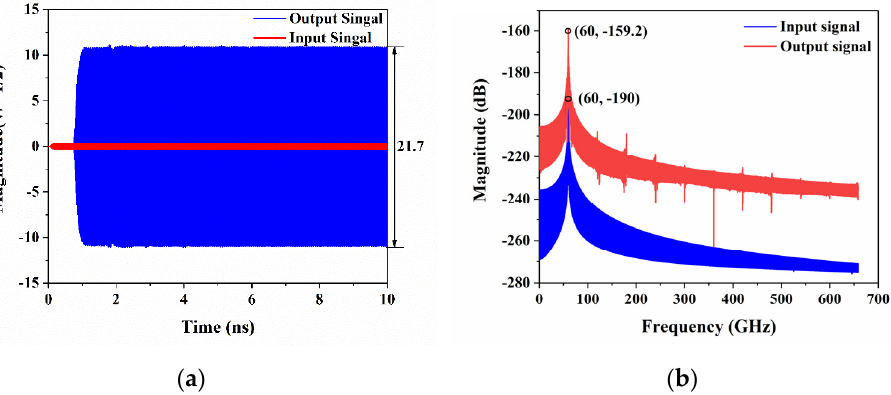
Figure 9. ( a ) Variation of input and output signals with time; ( b ) Fourier spectrum diagram of the output signal.